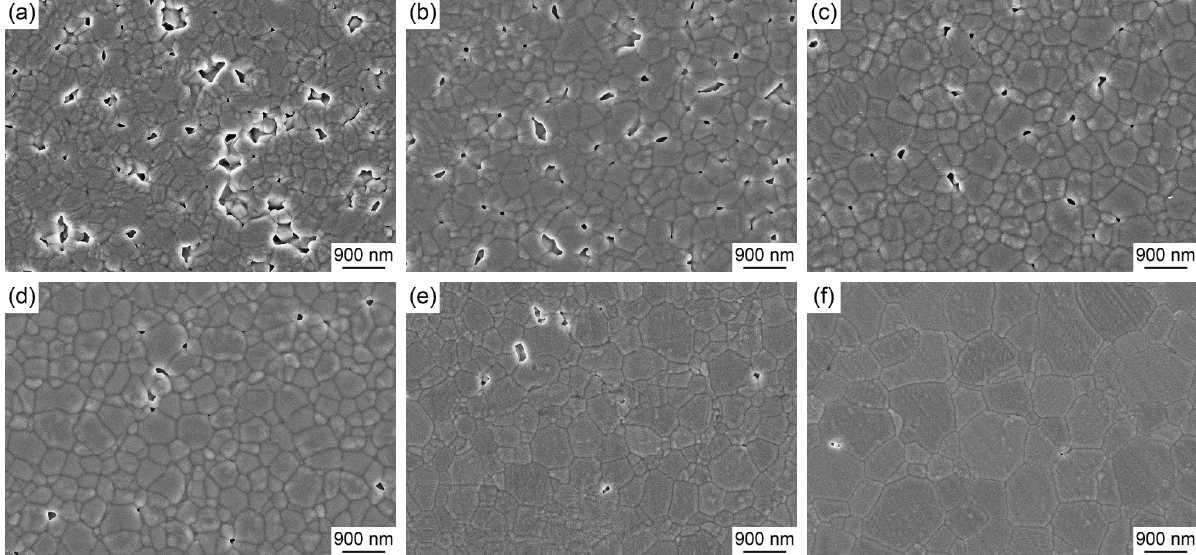
Fig. 3 FESEM micrographs of the thermally-etched surfaces of 8YSZ ceramics pre-sintered at (a) 1250 ℃ , (b) 1275 ℃ , (c) 1280 ℃ , (d) 1290 ℃ , (e) 1300 ℃ , and (f) 1325 ℃ for 4 h in